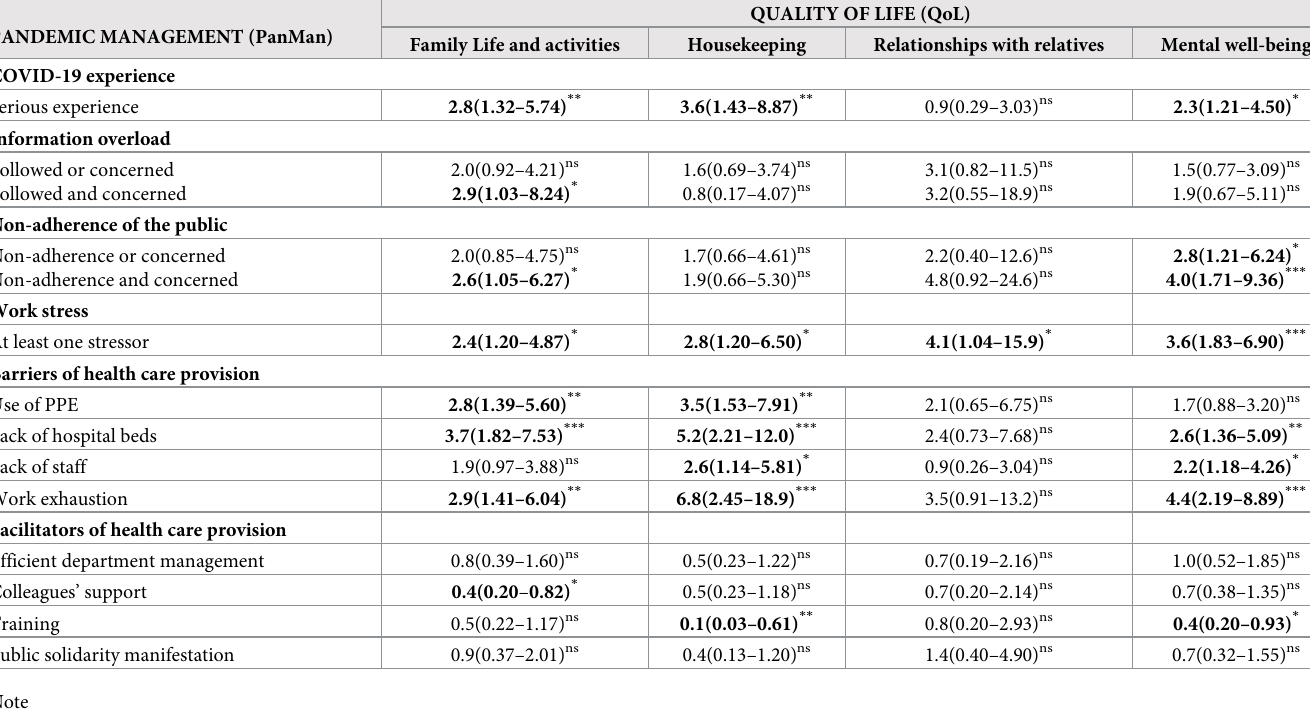
Table 3. Associations of PanMan with QoL of hospital HCWs during the second wave of the pandemic, logistic regression analyses adjusted for age and gender with odds ratios (OR) and 95% confidence interval (95%CI). PANDEMIC MANAGEMENT